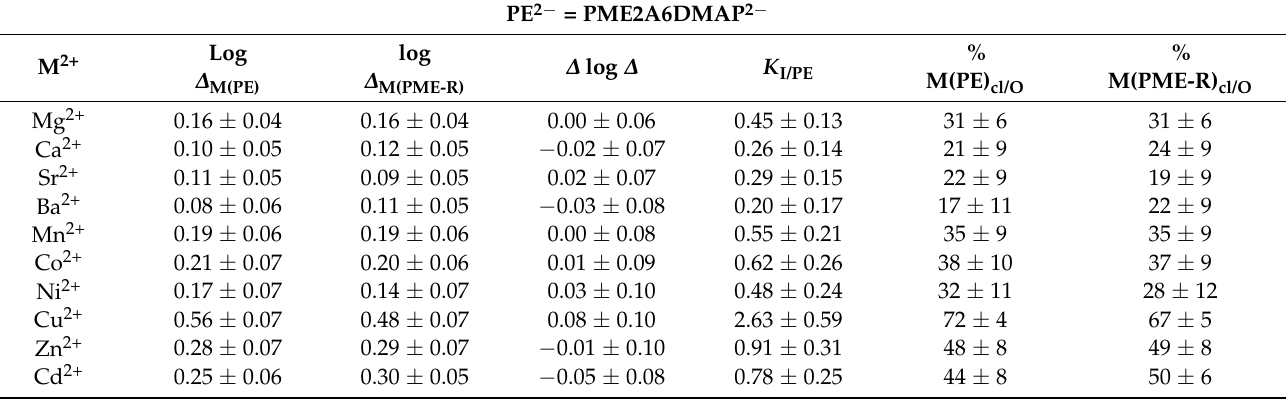
Table 5. Stability enhancements (Equation (12)) for the M(PME2A6DMAP) and M(PME-R) complexes and their comparison according to Equation (13). In addition, the extent of chelate formation according to Equilibrium (5) is given as expressed by the dimension-less equilibrium constant K I (Equations (6) and (10)) and the percentages of M(PME2A6DMAP) cl/O (Equation (14)). The values for % M(PME-R) cl/O are given for comparison. (Aqueous solution; 25 ◦ C; I = 0.1 M, NaNO 3 ) a . PE 2 − = PME2A6DMAP 2